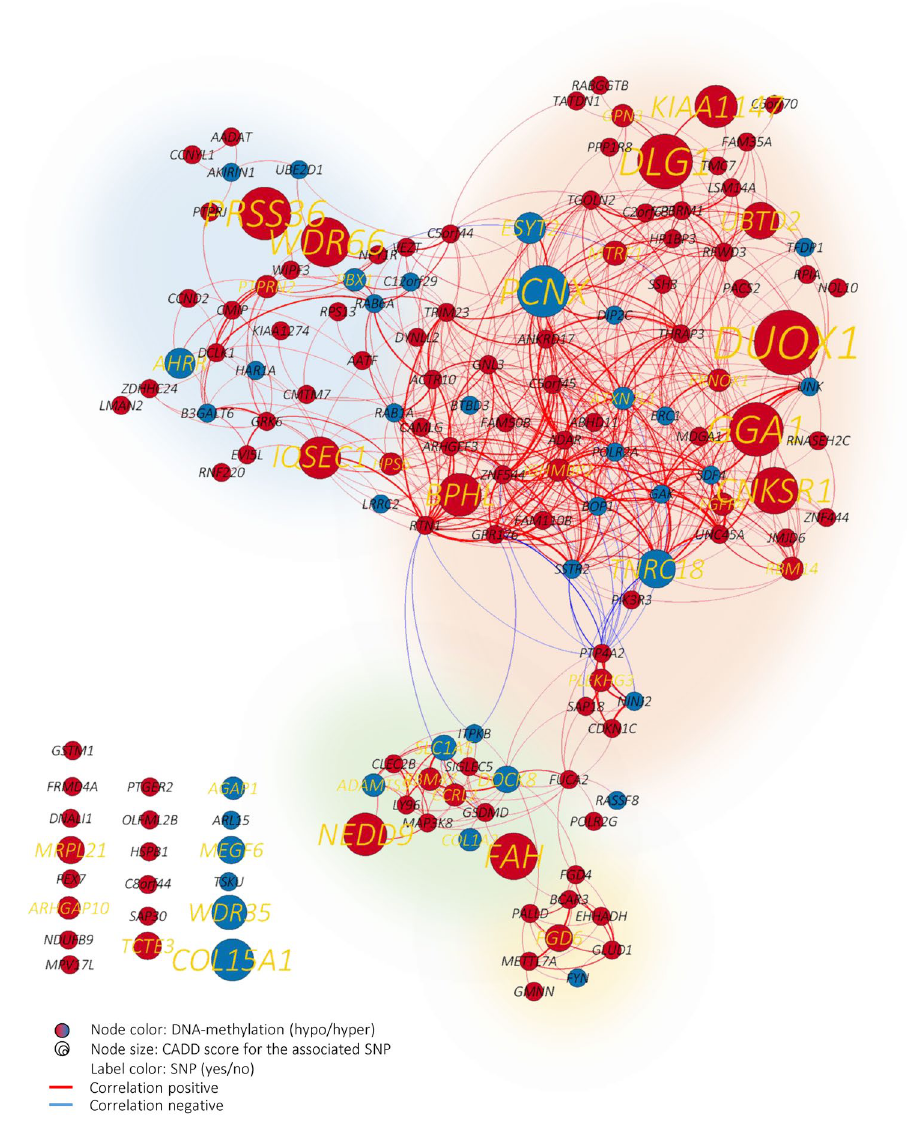
Figure 4. Co-expression network for FTD-ALS group. Continuous gene expression data from GTEx (n = 313 samples over 13 brain regions) was used to build a co-expression network using the genes that are marked being significantly differential DNA-methylated in FTD-ALS group, and with significant pairwise correlation (|r| > 0.6 and P < 0.001). Node color depicts DNA-methylation status of the gene; red color depicts DNA hypomethylation (T-statistics < 0), and blue color depicts DNA hypermethylation (T-statistics > 0). Node size and text label depicts CADD score for the associated SNP (larger node size depicts a relatively more deleterious variant, and genes without a SNP have equal small node size). Yellow colored text labels depict a SNP that associated with the gene from GWAS FTD-ALS, whereas a black color depicts no SNP. Edges with positive correlation are indicated in red, whereas negative correlations are indicated in blue. Thickness of edges is based on the absolute correlation measure, which varies between 0.6 and